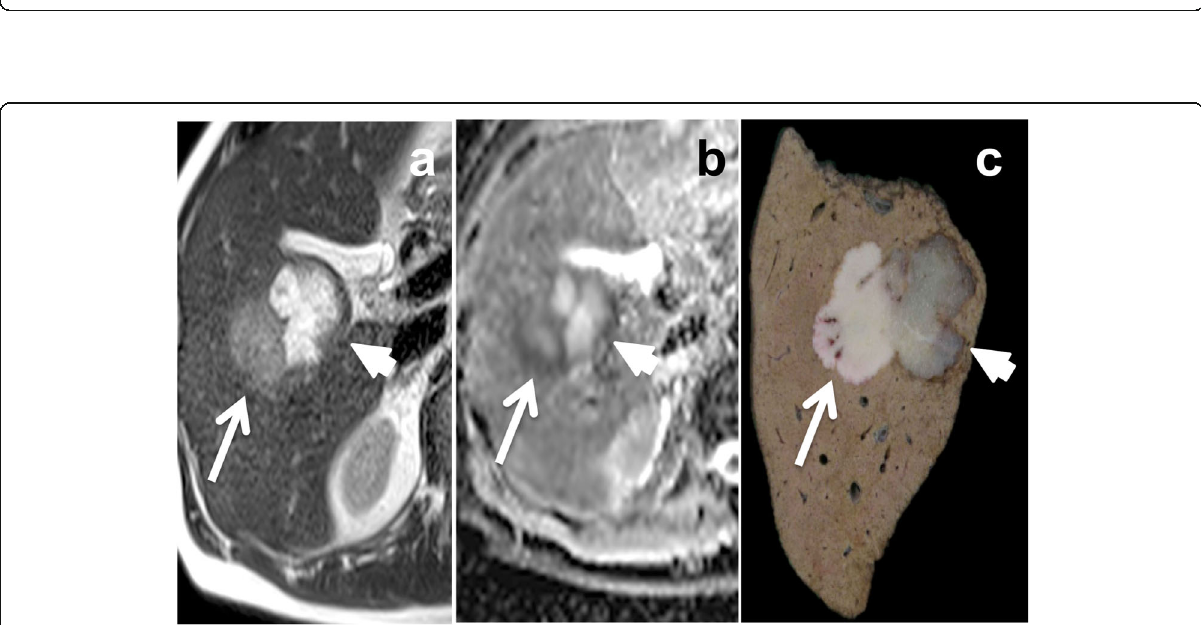
Fig. 16 Tumor regrowth with an appearance that is different from the initial tumor in a 72-year-old male patient with mucinous right colon cancer and liver metastases. The patient received 12 cycles of FOLFOX with an objective response. Preoperative MR imaging was performed after right portal vein embolization and after discontinuation of chemotherapy for 8 weeks and showed a mucinous metastasis with a peripheral, focal, non-mucinous glandular proliferation. The initial mucinous metastasis was seen medially (arrowheads) with high signal intensity on fast spin echo T2-weighted images ( a ) and a central high apparent diffusion coefficient (ADC) ( b ). The focal regrowth was seen laterally (arrows) with mild signal intensity on fast spin echo T2-weighted image ( a ) and diffusion restriction with a low ADC ( b ). Gross pathology ( c ) confirmed the presence of a metastasis of mucinous adenocarcinoma (arrowhead) with non-mucinous focal regrowth